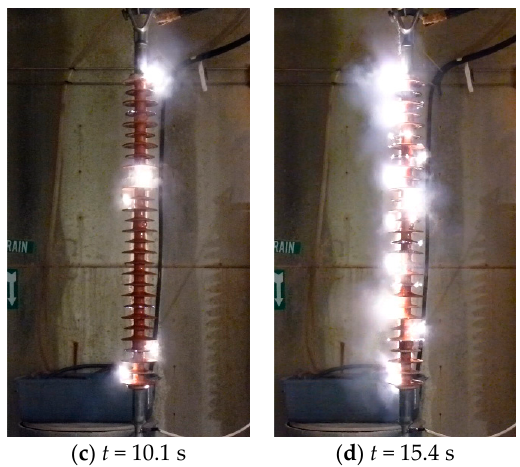
Figure 12. The experiment results at different time nodes of dry bands formation and arc propagation Figure 12. processes.